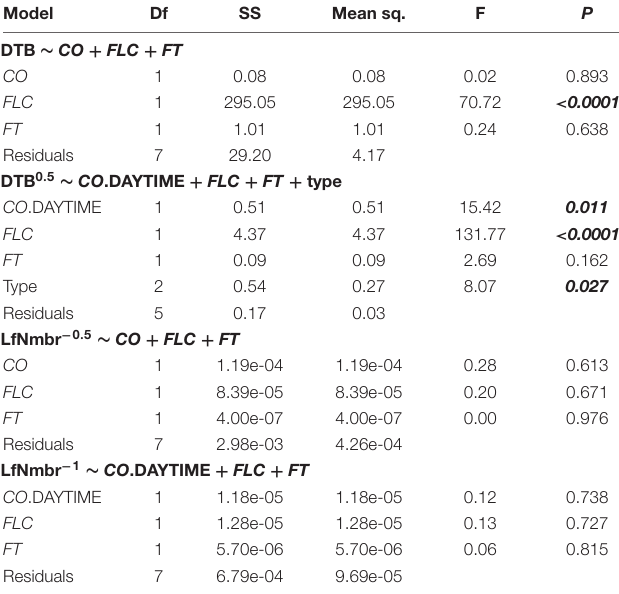
TABLE 1 | Results of analysis of variance (ANOVA) for days to bolt (DTB) and rosette leaf number (LfNmbr) relative to FLOWERING LOCUS T ( FT ), CONSTANS ( CO ), FLOWERING LOCUS C ( FLC ), and flowering